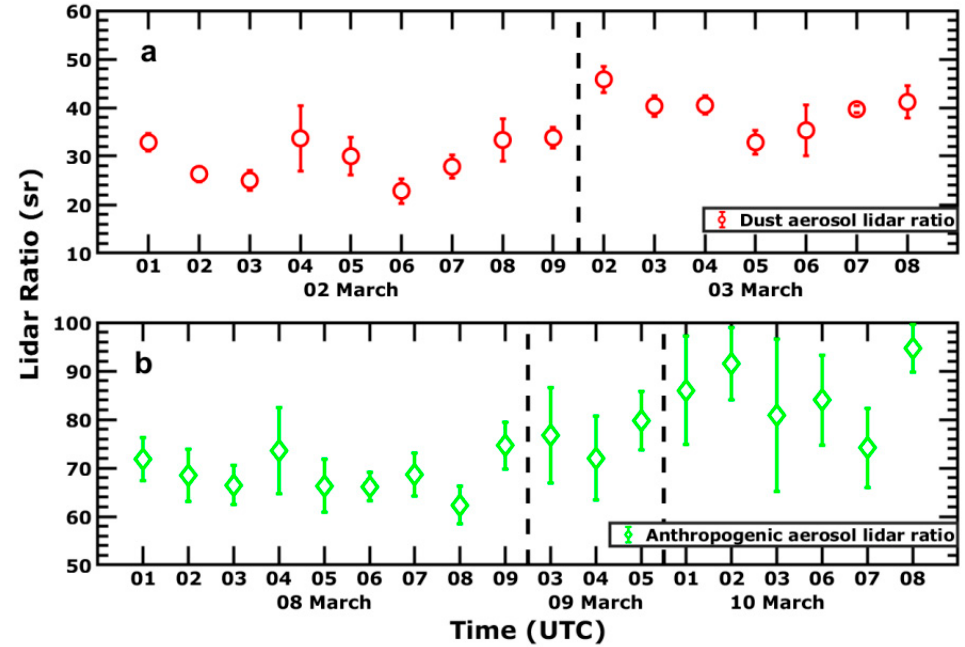
Figure 3. Results of aerosol lidar ratio calculated by lidar combined with sun photometer (( a ) the dust aerosol lidar ratio; ( b ) the anthropogenic aerosol lidar ratio).